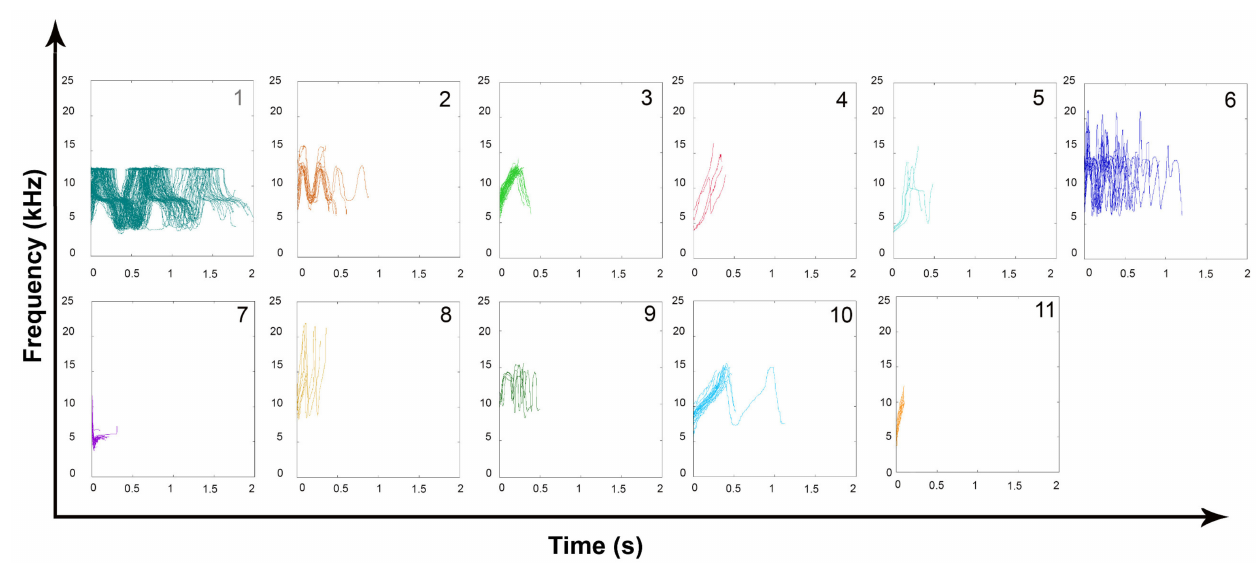
Figure 2. Pitch contours extracted for the 11 signature whistle types identified using the SIG-ID method